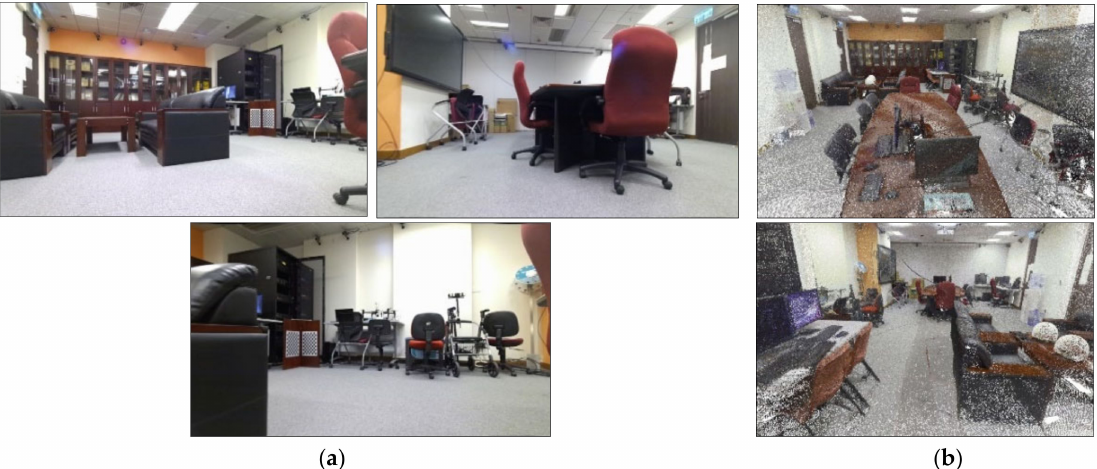
Figure 9. Texture-rich setup. ( a ) The left three frames show the surveying environment containing some texture-rich regions. ( b ) Ground truth model using the Leica RTC360 3D laser scanner.